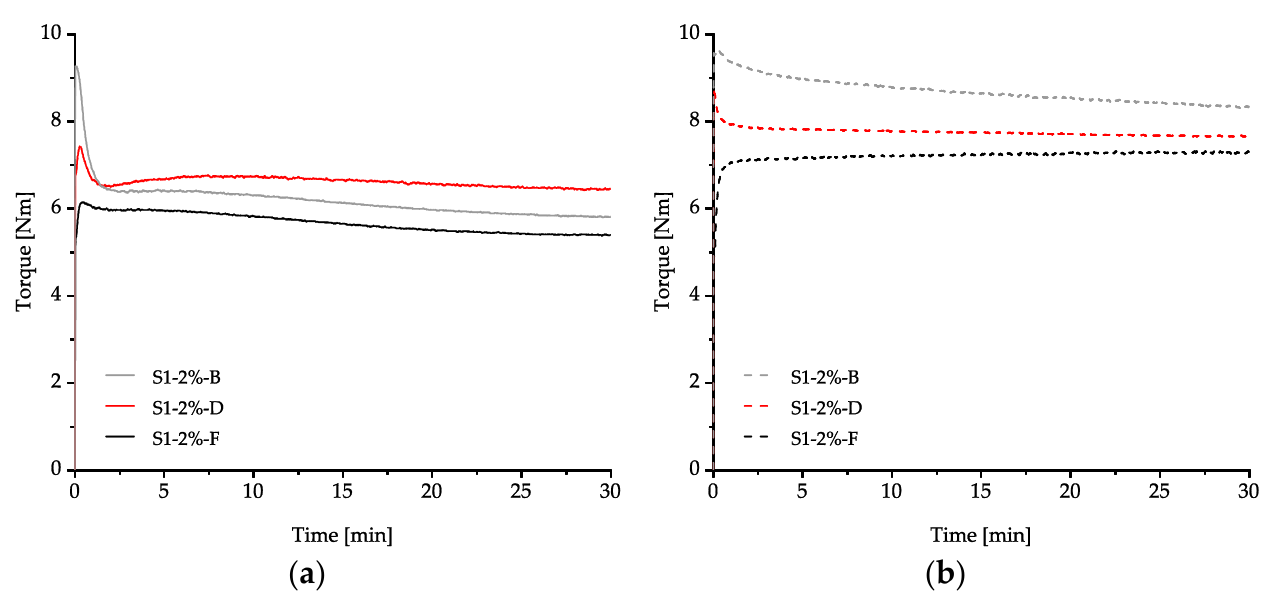
Figure 7. Rheometer curves recorded at 180 °C ( a ) and 120 °C ( b ) of S1-2%-B, S1-2%-D (120 °C), and S1-2%-F (50 rpm, 4.5 gpm).